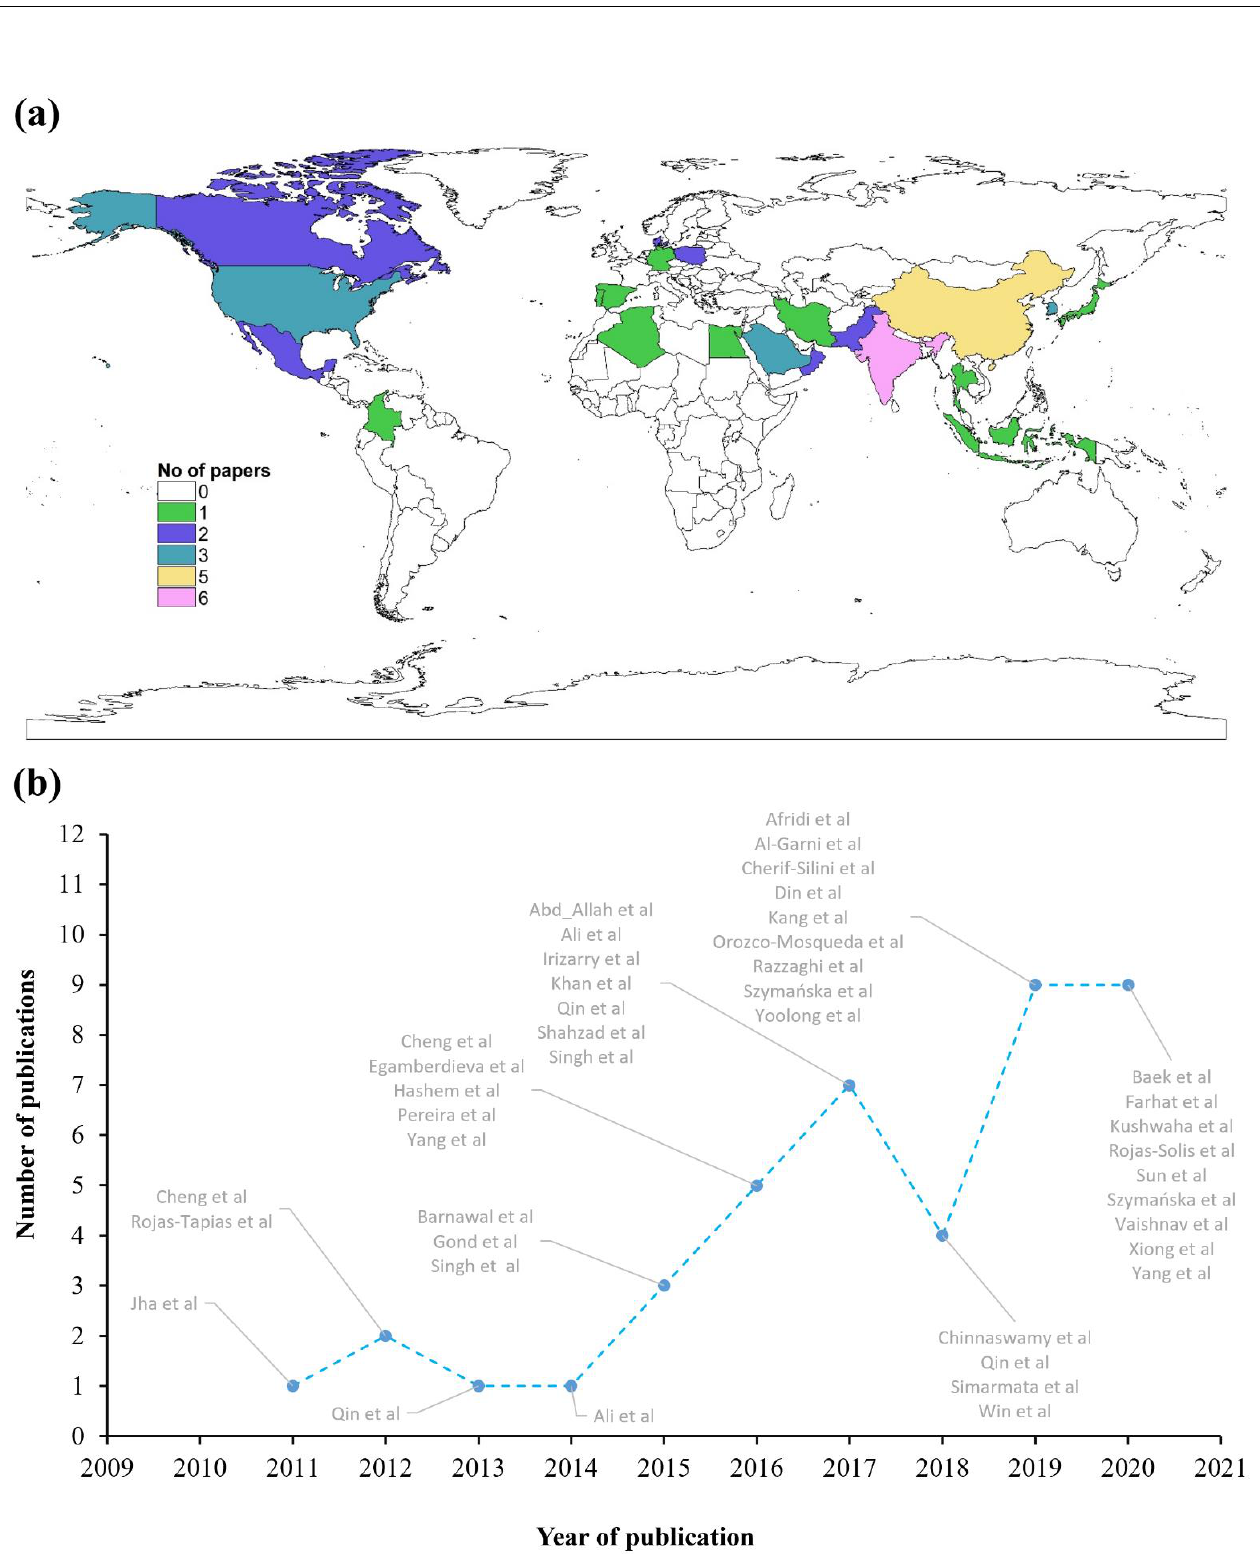
Figure 1. ( a ) Location of the experiments obtained from the selected studies (42) used in this meta-analysis (https://www.r-spatial.org/r/2018/10/25/ggplot2-sf.html (accessed on 31 December 2020)) and ( b ) the accumulated number of publications reported within the last 10 years (2011–2020) used in this meta-analysis. Data labels on each scatter point show the author names in that